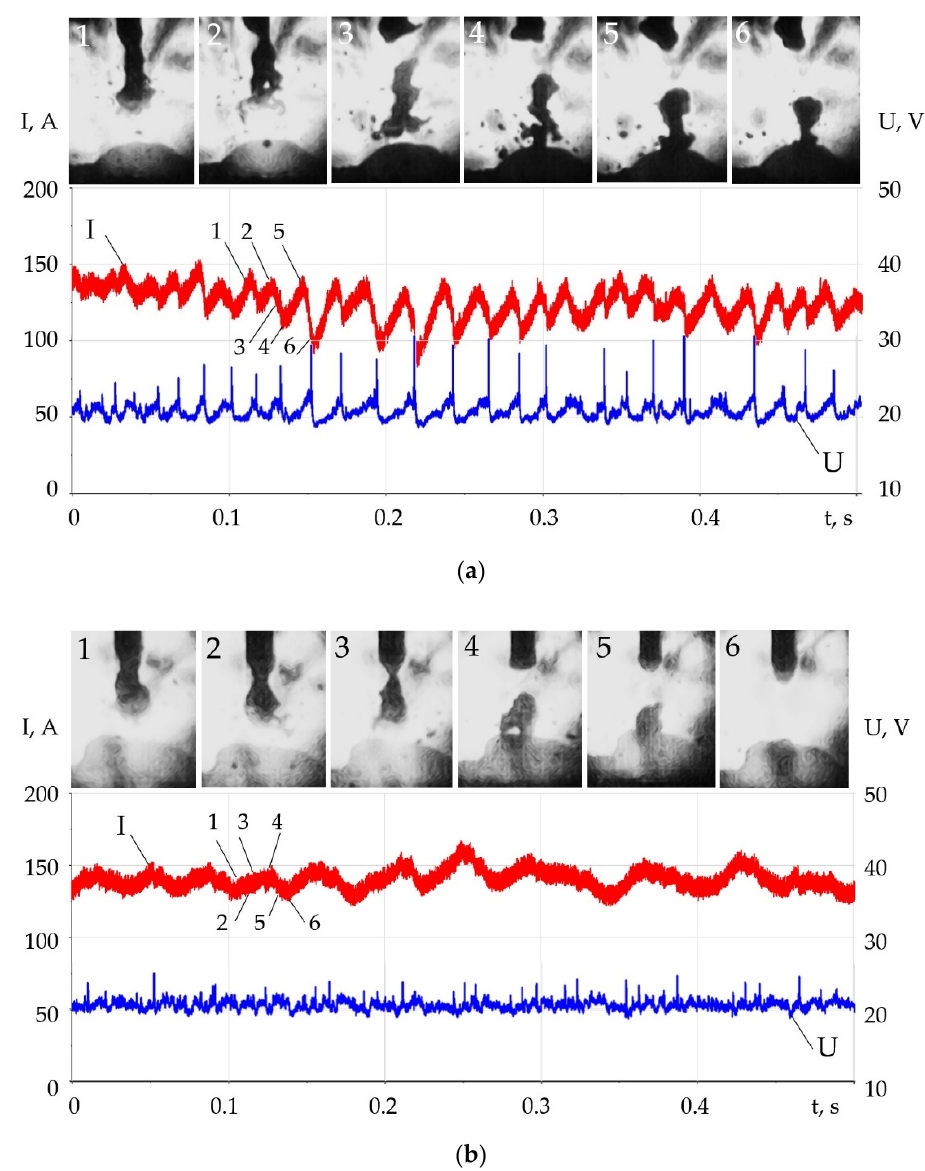
Figure 15. Change in the current and sequence of droplet transfer during melting AlMg5Mn1Ti wire of 1.6 mm: ( a ) pure argon; ( b ) gas mixture, wt.%: 98.4Ar+1.6SF 6 . Time between the frames is 5 ms; 1–6 is a sequence of frames.